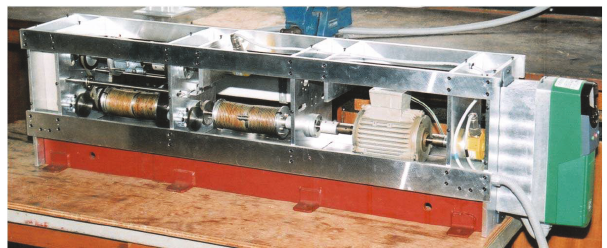
Figure 6: The nonminimum phase plant experimental test facility